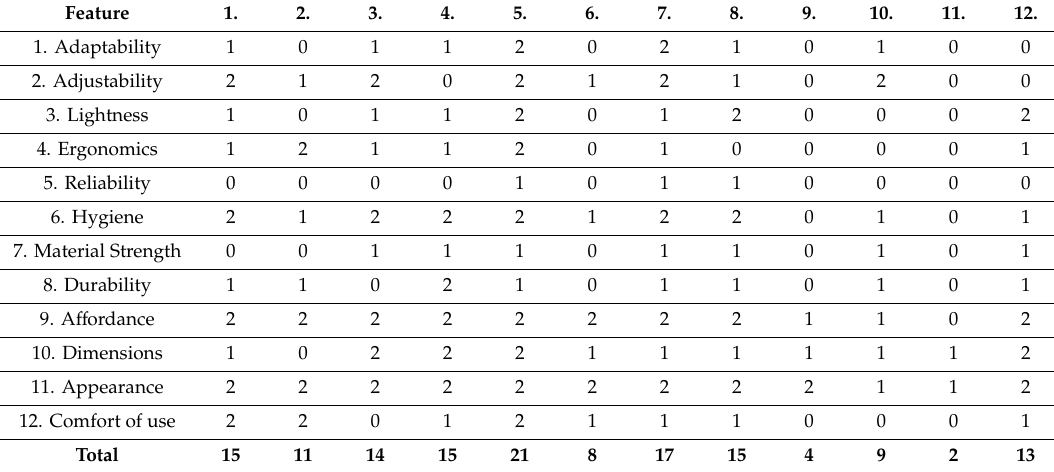
Table 1. Relationship Matrix: Relative Importance.